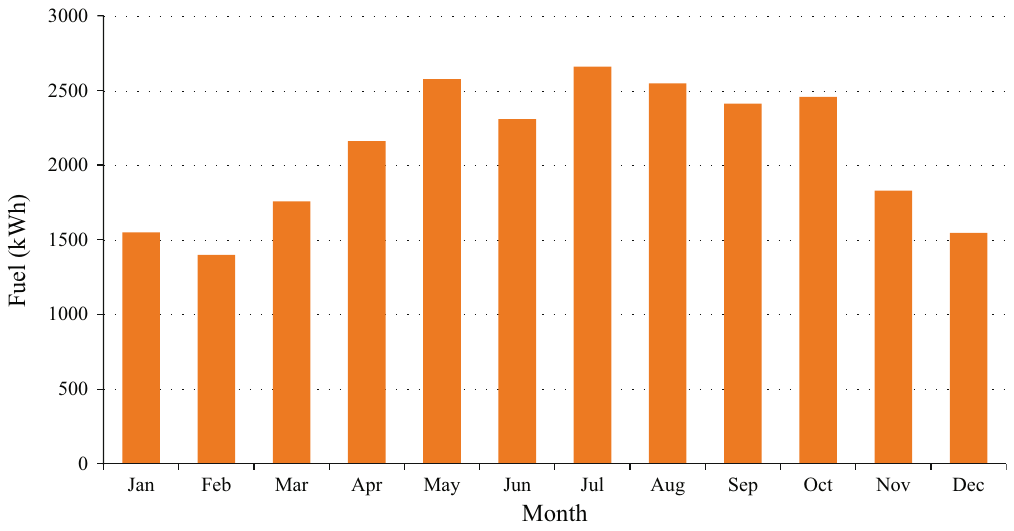
Figure 12: The total monthly consumed load of the building without consideration of energy